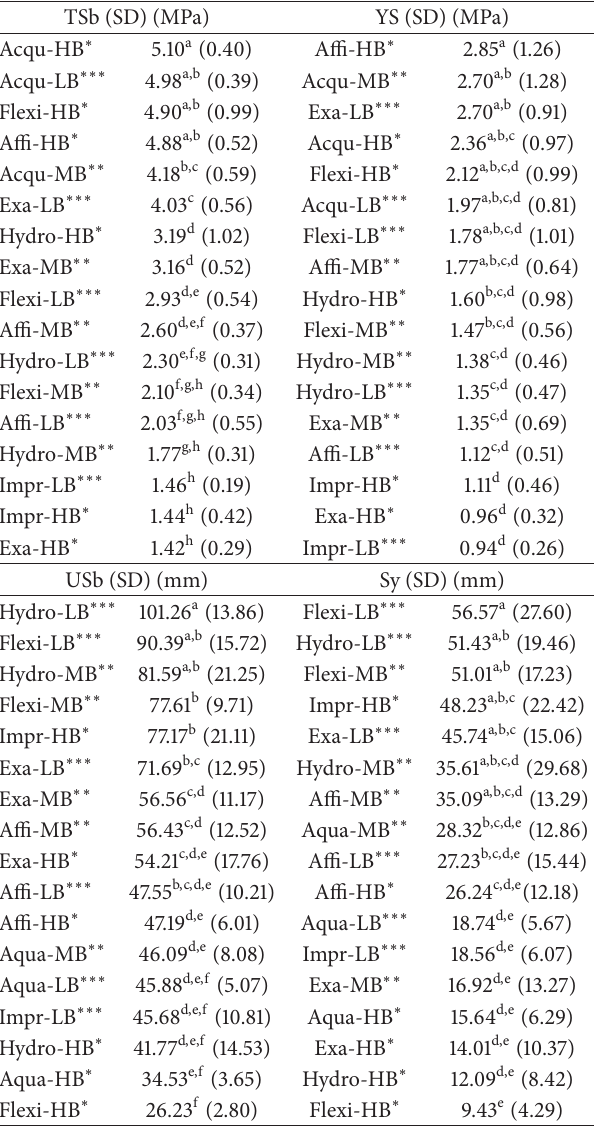
The same superscript letters indicate no statistically significant differences ( 𝑃 > 0.05